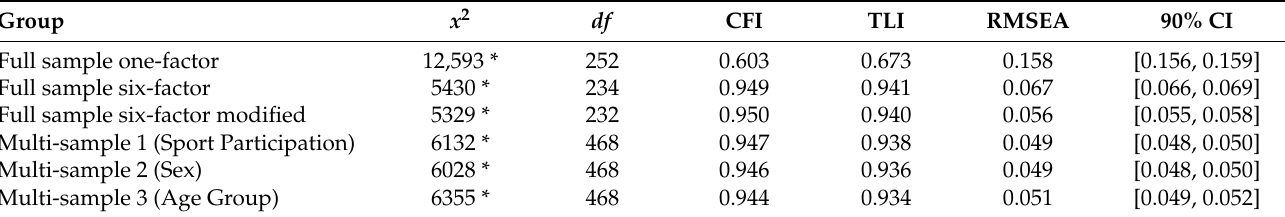
Table 2. Model testing of the MASMS ( n = 4923).